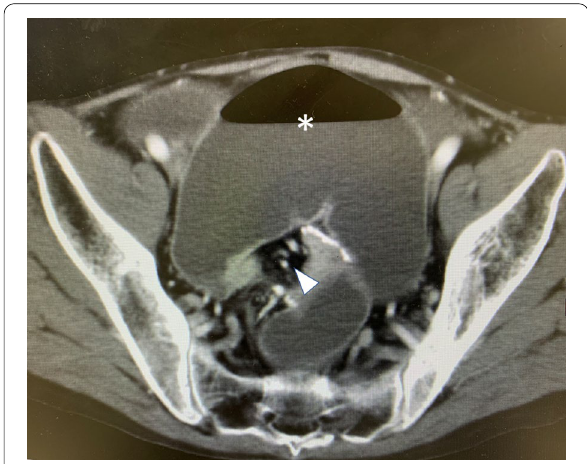
Fig. 2 Enhanced multidetector computed tomography demonstrates a whirl sign at the upper corner of the pouch. White up-pointing triangle: superior mesenteric artery and vein, *: dilated oral ileum